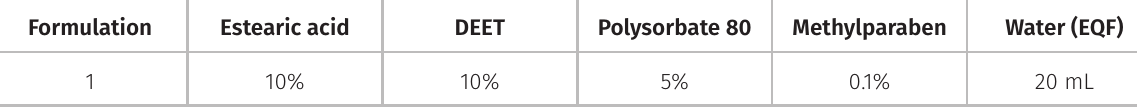
Table I. Formulation of Solid Lipid Microparticles containing DEET.